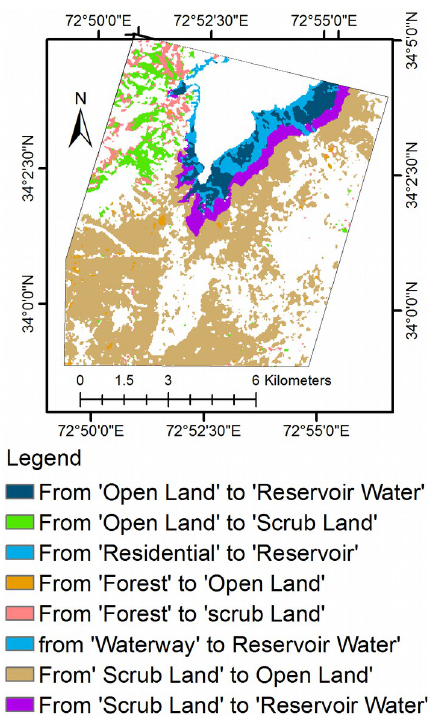
Figure 6. S pring to autumn seasonal change detection 3.8 Seasonal Change Detection from Summer to Autumn Change detection matrix from Summer to Autumn shows (Table 7) decrease of spatial mapping of residential land 13.5%, reservoir water 5.2%, forest 13.2%, waterway 10.3% scrub land 6.1%, and increase of open land 25.5%. Figure 7 shows a category changes from residential land to open land, from reservoir water to open land, from waterway to open land, from scrub land to open land which resulted increase in open land. Change of category from open land to scrub land, residential land to open land resulted due to seasonal change. Small change from open land to residential land resulted due to lack of vegetation cover the buildings and some misclassification. Seasonal change detection from summer to autumn resulted increase of open